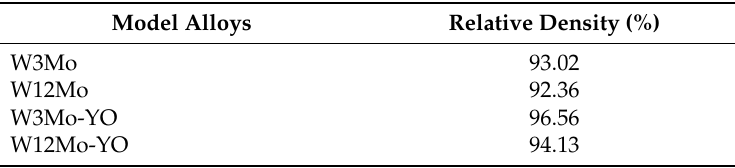
Table 2. The relative densities of the W-Mo-Ni-Fe-Co model alloys (%).